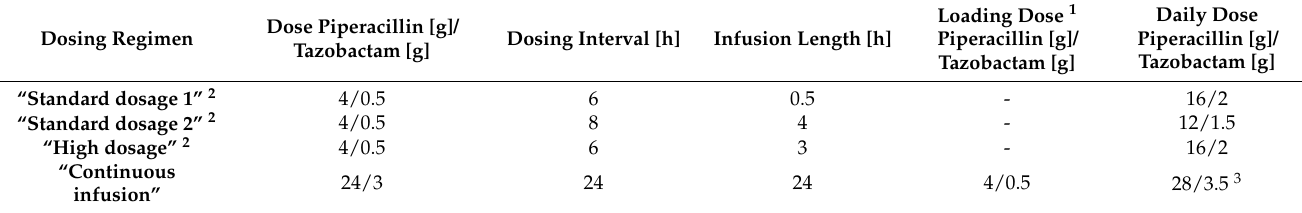
Table 2. Summary of the model-evaluated intravenous dosing regimens of piperacillin/tazobactam. Dosing